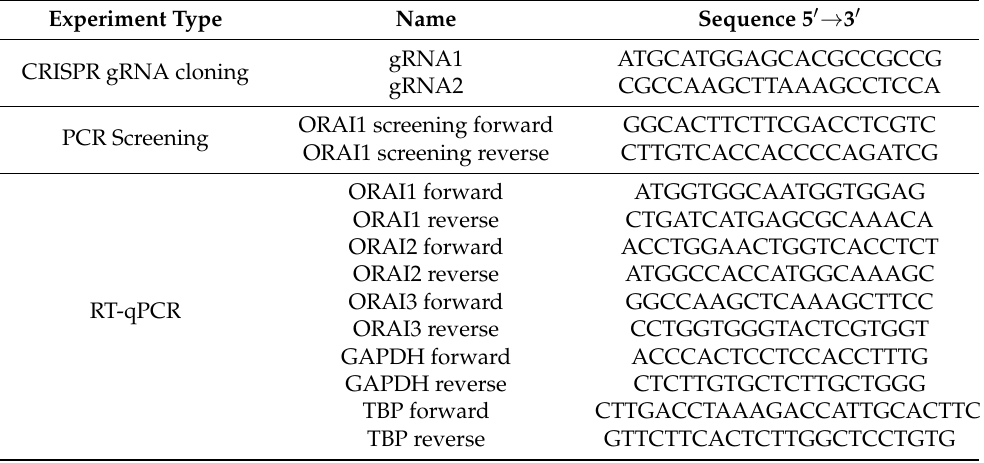
Table 1. Oligonucleotides used for cloning, polymerase chain reaction (PCR), and quantitative reverse-transcription PCR